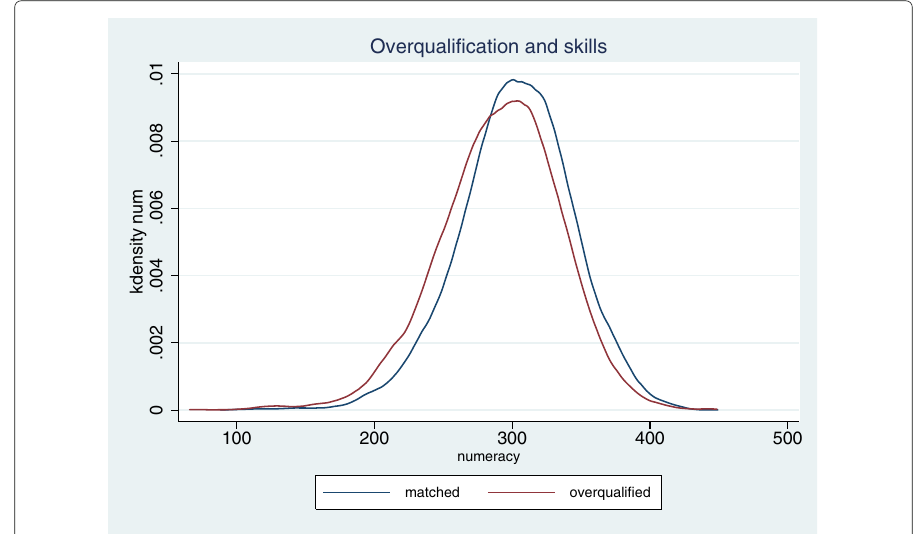
Fig. 1 Numeracy of over-qualified